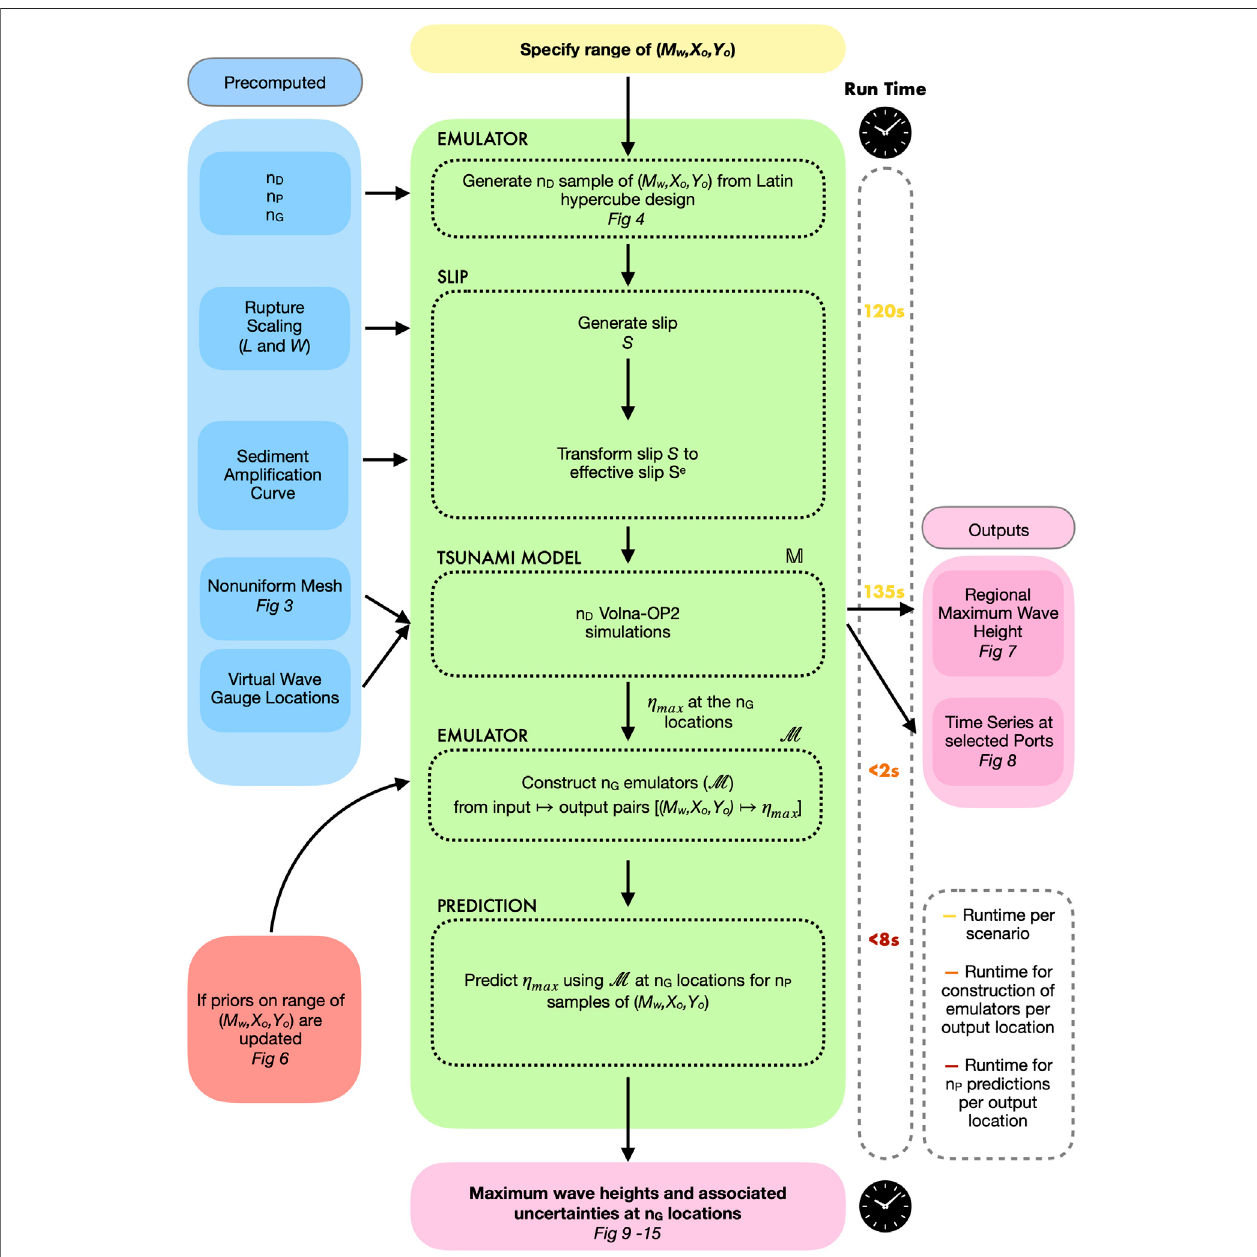
FIGURE 1 | Flowchart of the proposed work fl ow. n D is the number of sample earthquake sources (training set), n P is the number of prediction scenarios and n G is the number of output locations where the emulators are constructed. The runtimes quoted in this work fl ow are time per source, time for construction of emulators per outputlocationortimeper predictions atanoutputlocation. η max isde fi nedasmaximumwaveheight. Theoutputsintherightcolumncome directlyfromtheVolna-OP2 simulations, while the outputs at the bottom are obtained using the